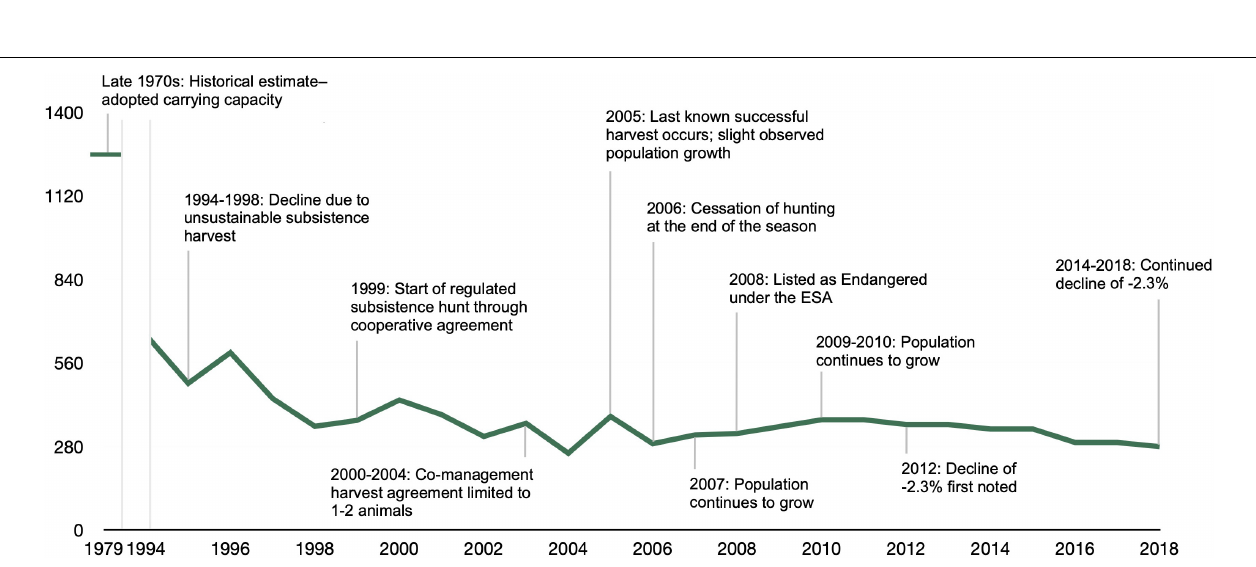
FIGURE 1 | Map of geographic locations of CIB (green) and the three surrogate odontocete populations: St Lawrence beluga (yellow), Hector’s dolphins (purple), and southern resident killer whales (red).